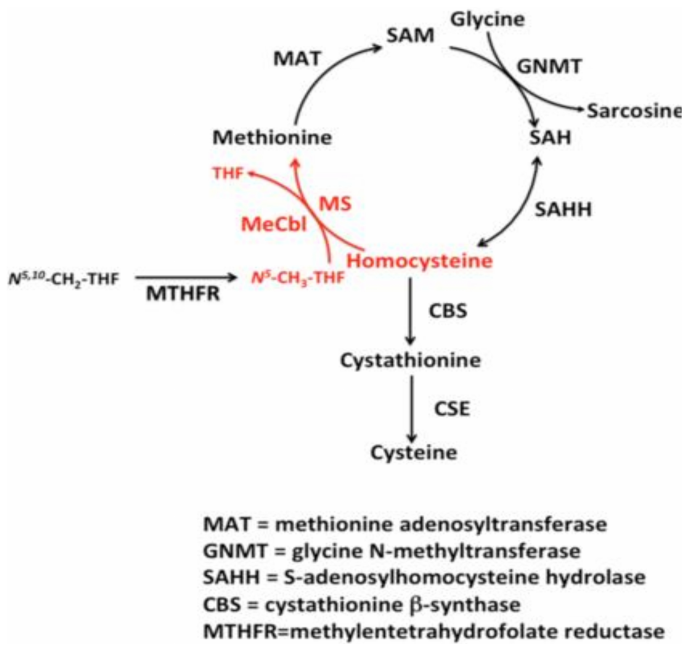
Figure 1. Homocysteine (Hcy)